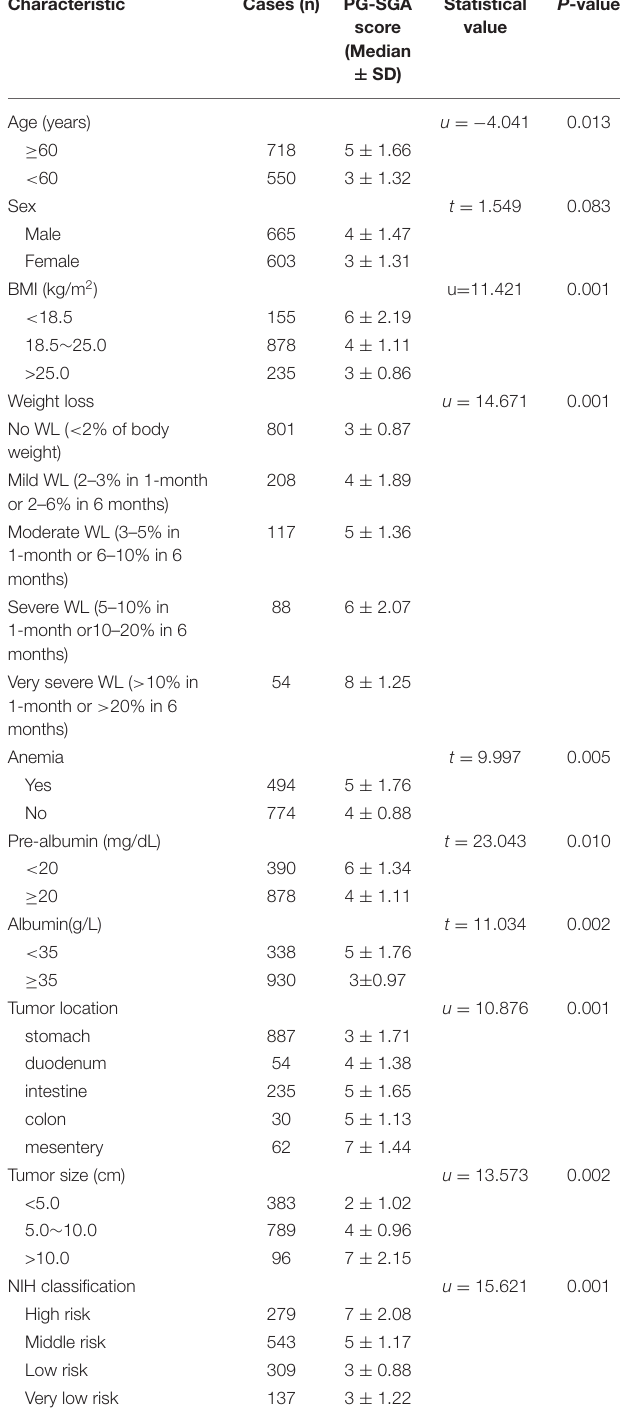
TABLE 5 | Analysis of PG-SGA score with factors affecting nutritional